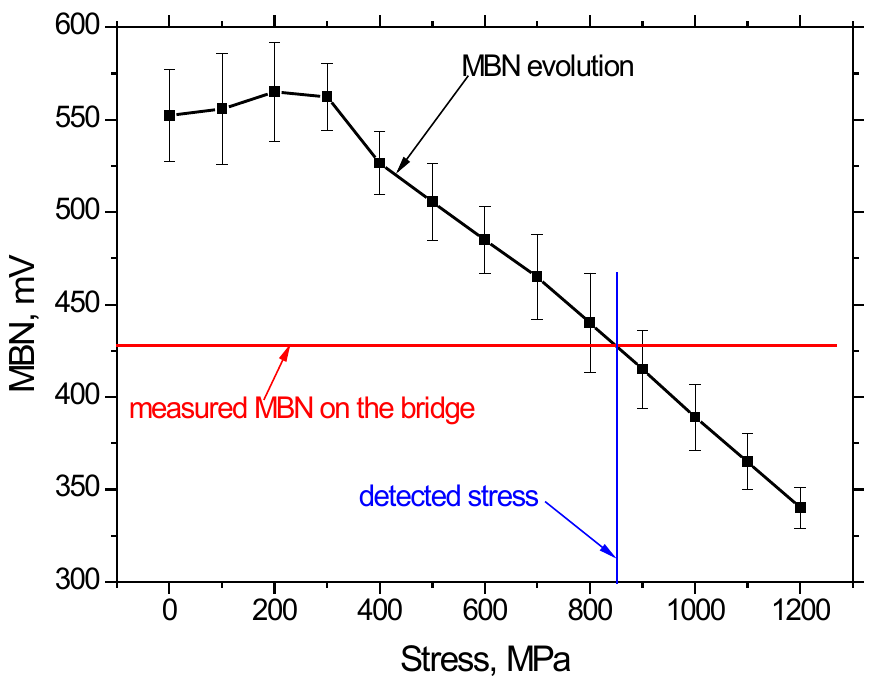
Figure 24. Evolution of MBN versus tensile stress state together with assessment of the true stress of prestressed wire.